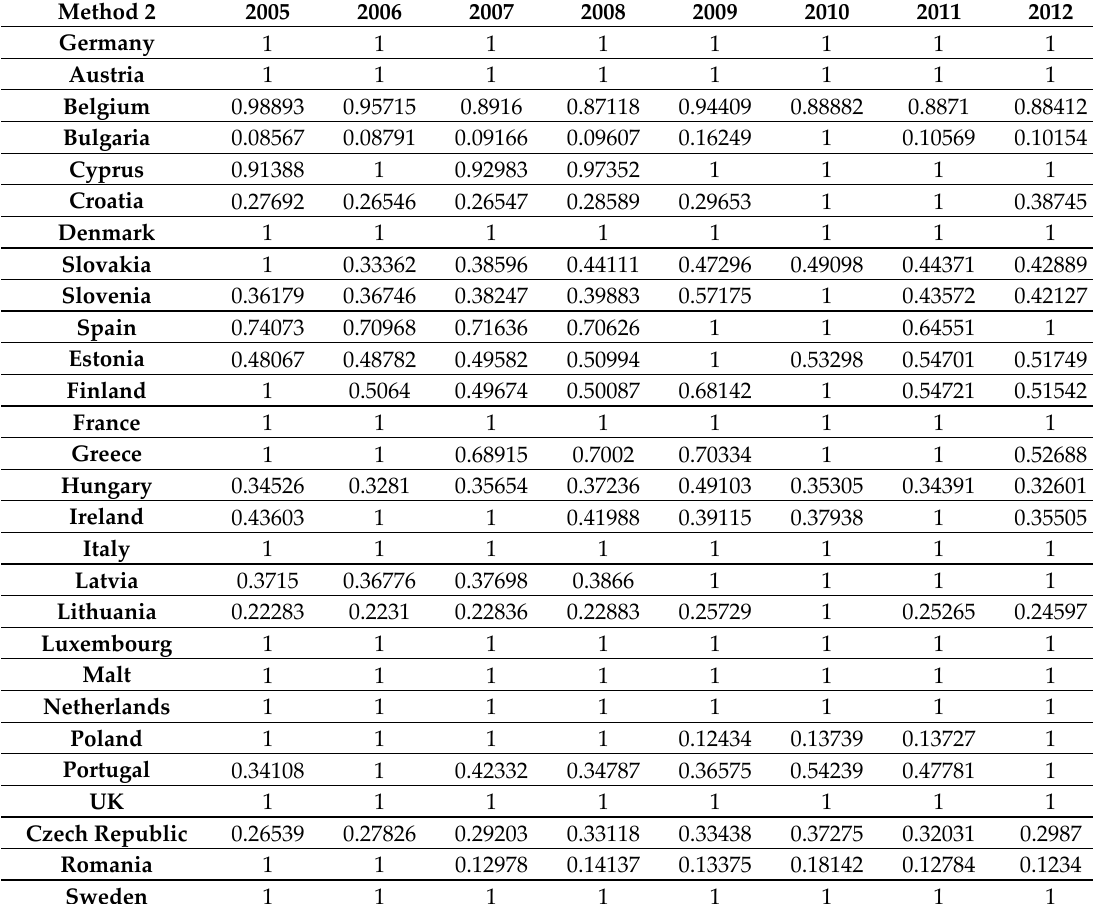
Table 5. Environmental efficiency values for the 28 countries (2005–2012) obtained with Method 2. Source: own